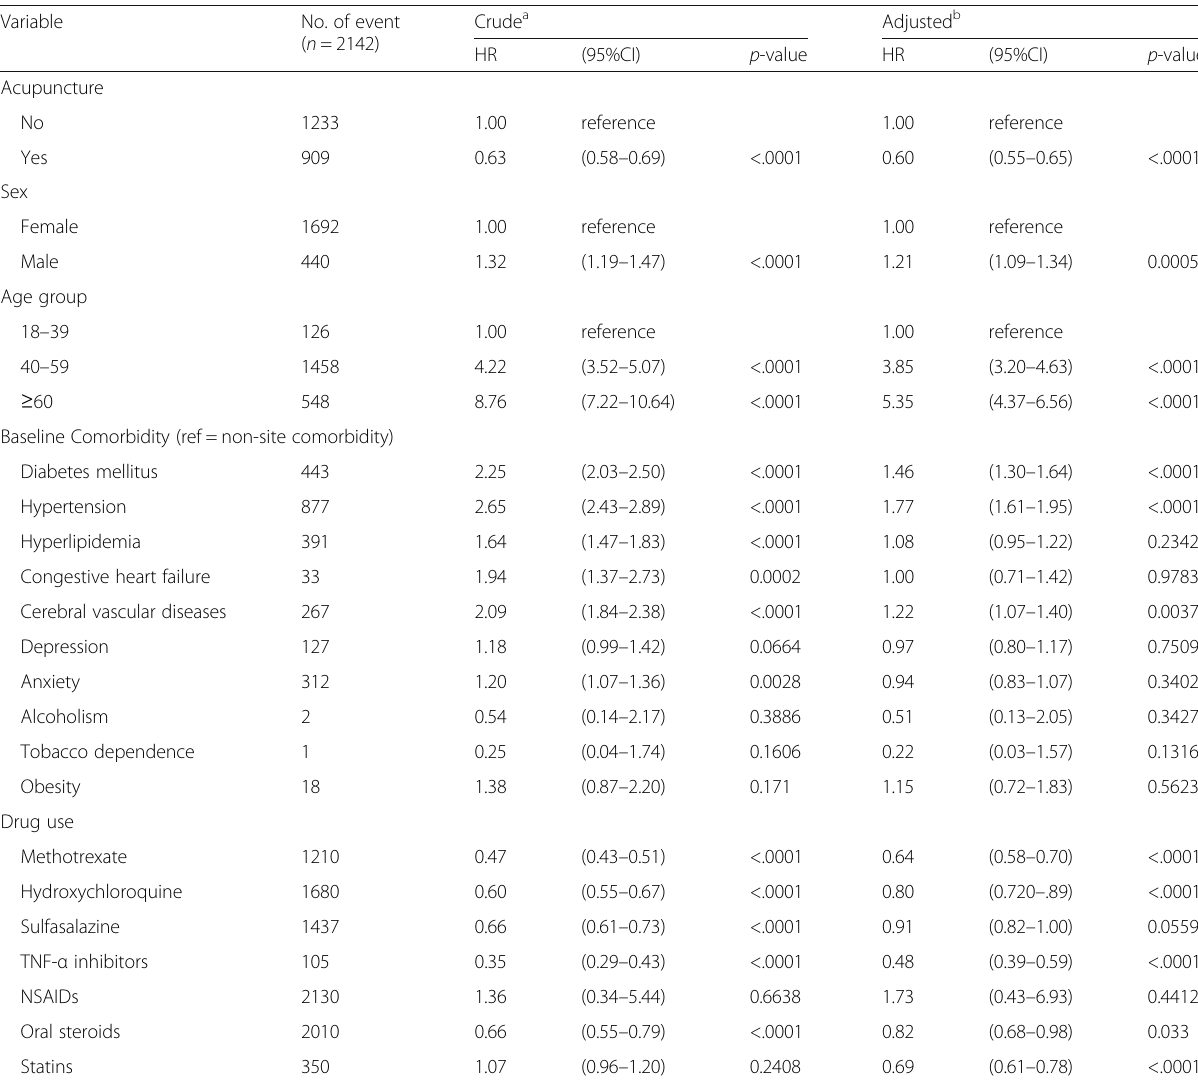
Table 2 Cox model with hazard ratios and 95% confidence intervals for coronary heart disease in patients with rheumatoid arthritis who did or did not receive acupuncture treatment